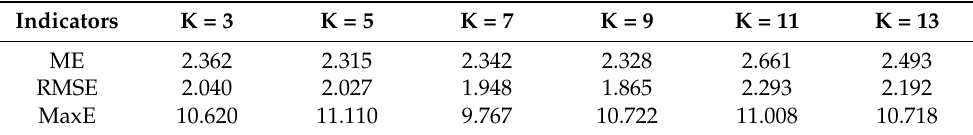
Table 4. Statistics of positioning errors of the proposed method with different K values (m).